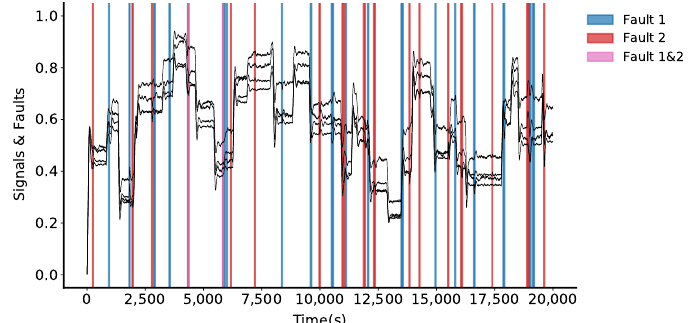
Figure 4. Actuator faults in an extract of the data-set, shaded areas indicate that a fault has occurred, and signals are normalized.